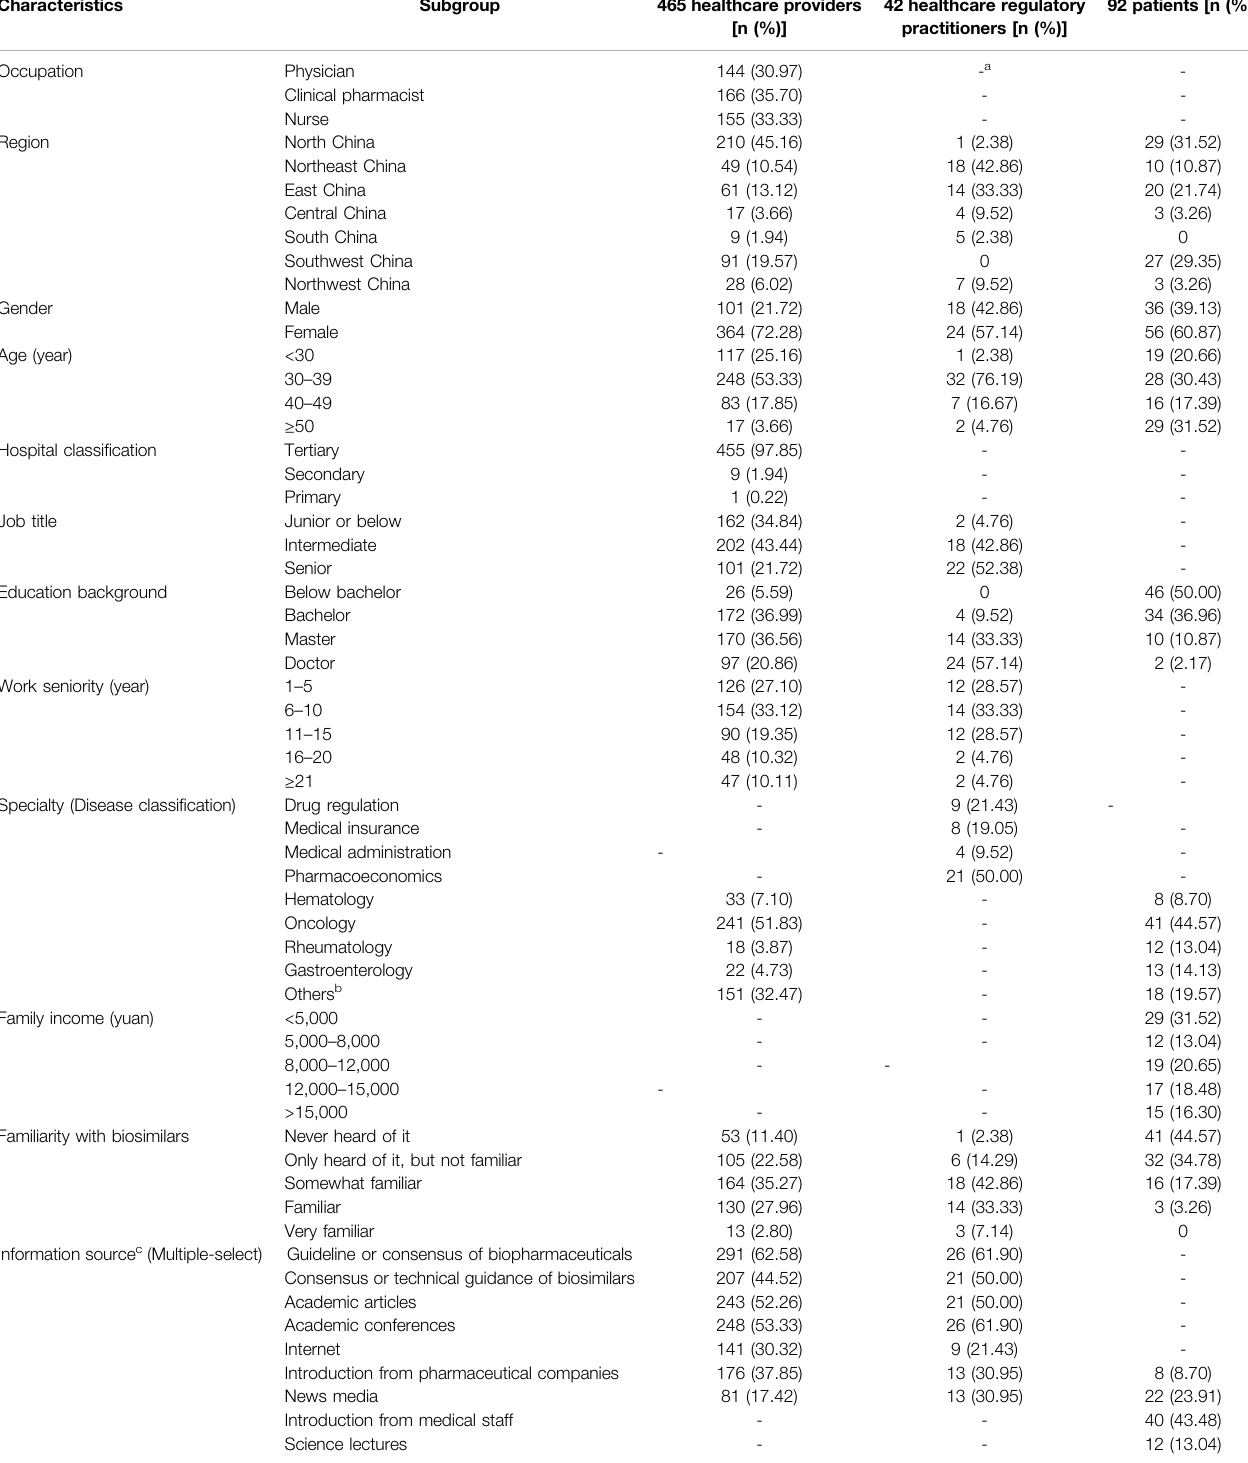
TABLE 1 | Demographic characteristics of